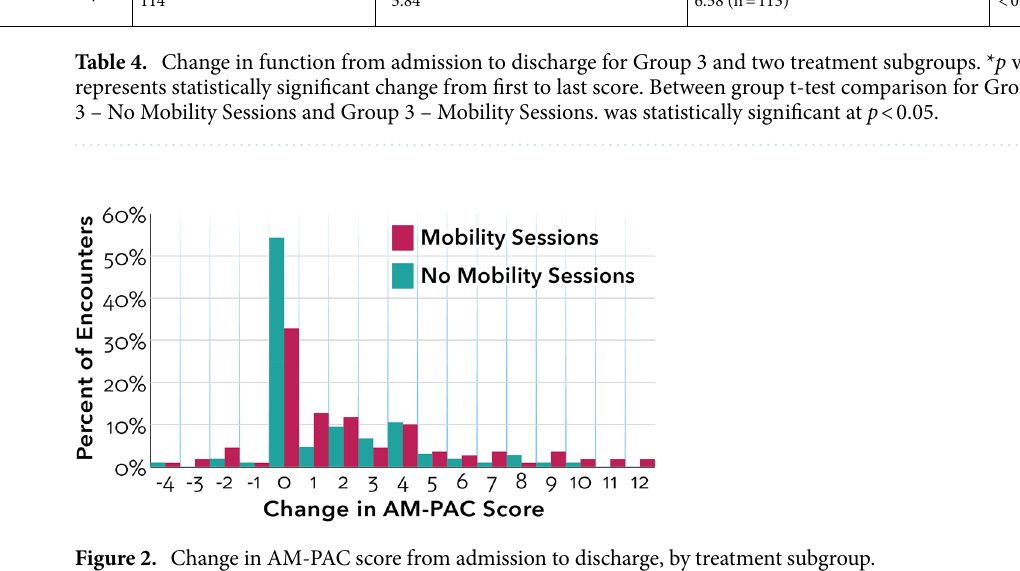
Figure 2. Change in AM-PAC score from admission to discharge, by treatment